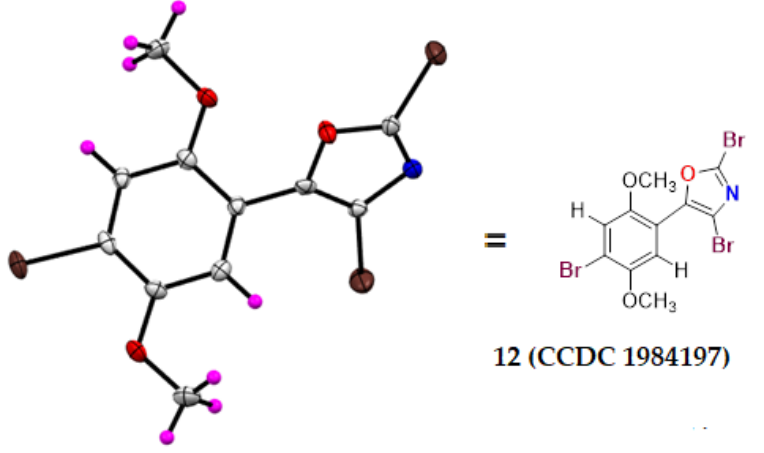
Figure 2. Single-crystal X-ray structure of compound 12.